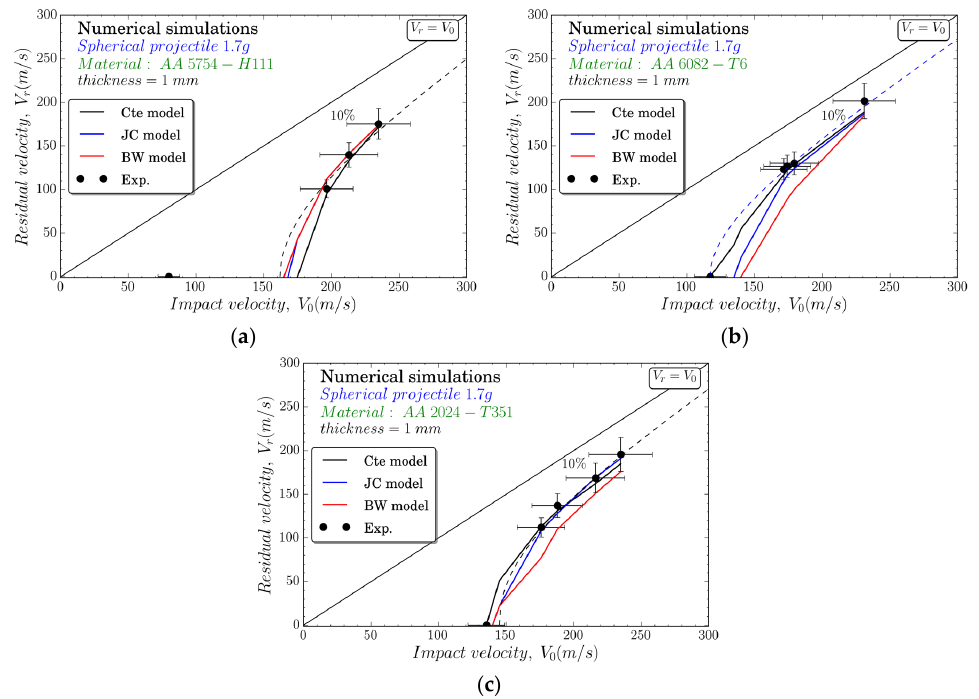
Figure 15. Spherical projectile configuration. Thickness = 1 mm. Comparison of residual velocity V r versus impact velocity V 0 between experiments and numerical simulations for: ( a ) AA 5754 ‐ H111; ( b ) AA 6082 ‐ T6; ( c ) AA 2024 ‐ T351. Blunt Projectile Configuration